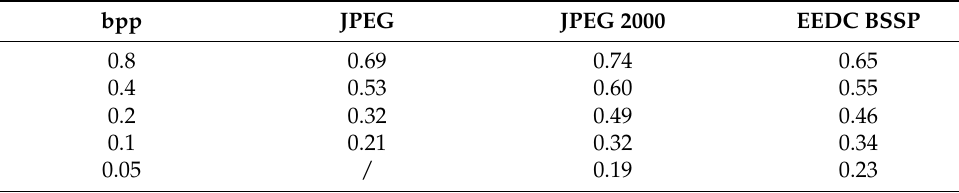
Table 14. Results of the VIF metric for image beauty .